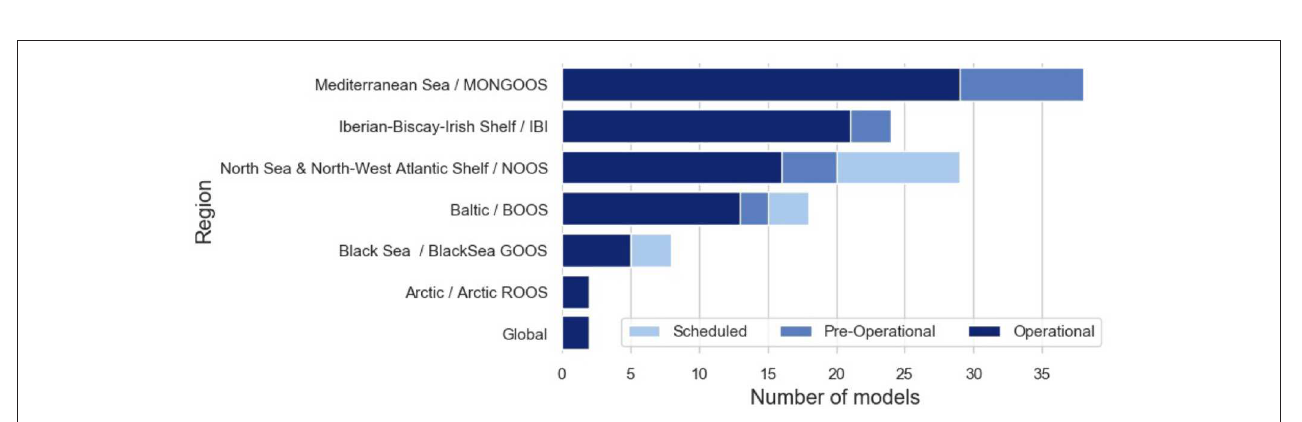
FIGURE 2 | Number of model implementations per